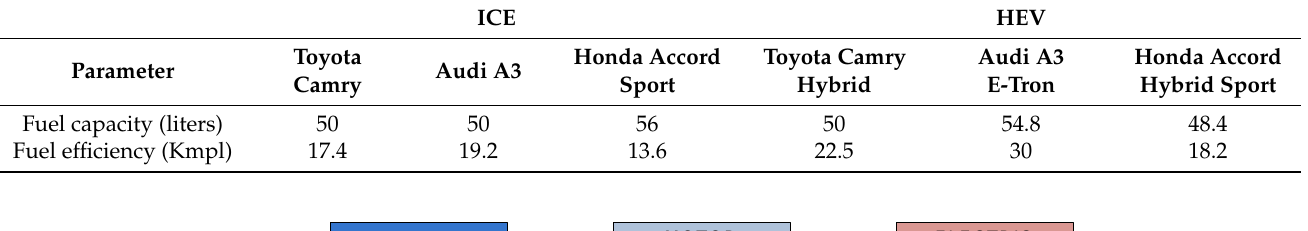
Table 1. Comparison of HEVs and an IC engine.